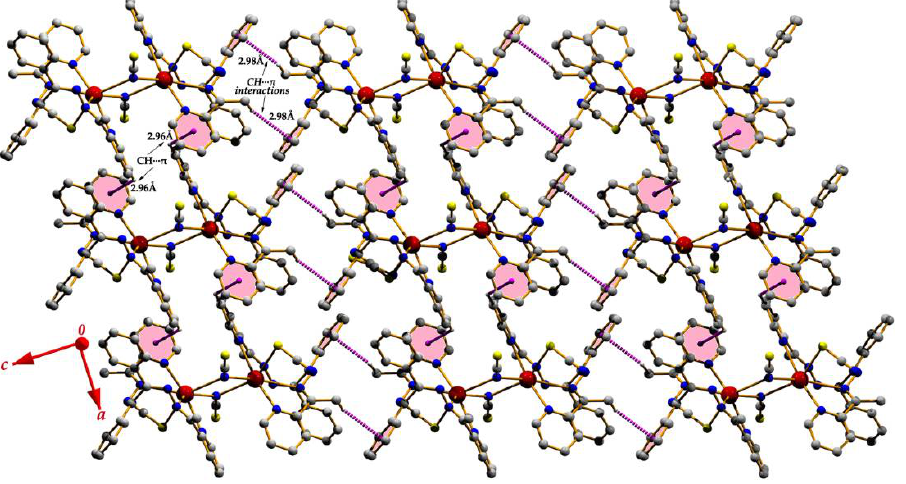
Figure 3. Self-assembled supramolecular framework in ( 1 ) in (101) plane through C‒H∙∙∙π interactions. Compound ( 1 ): Cg(2) and Cg(4) are the centroids of the rings generated through the atoms Table 3. Relevant hydrogen bonding parameters of compounds ( 1 ) and ( 2 ). (N6 / C24–C28) and (C16–C21), respectively. Compound ( 2 ): Cg(18) is the centroid of the ring generated through the atoms (N1 /